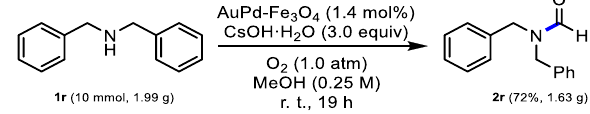
Scheme 6. Gram scale reaction.